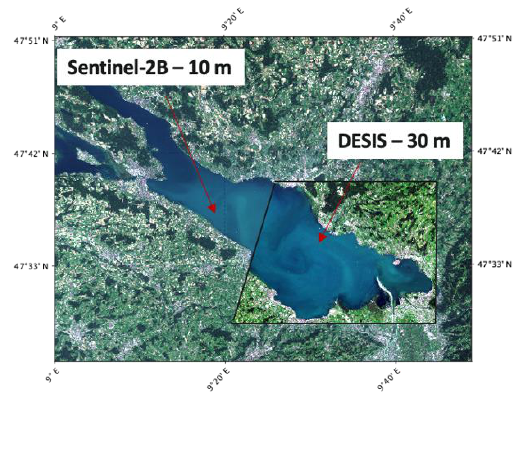
Figure 1 . Lake Constance true colour composites of Level 1 (R:665, G:560, B:490) on 08 August 2021: top – Sentinel 2B- MSI overlayed with DESIS, bottom –